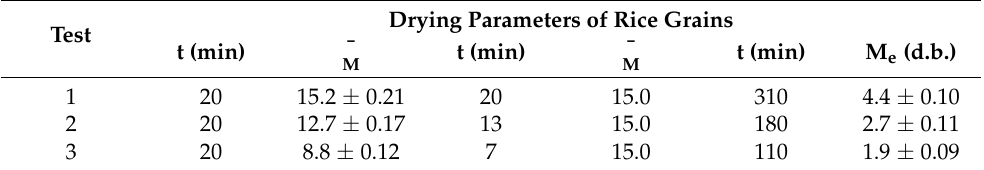
Figure 3. Effect of the supplied microwave power on the average moisture content of rice grains during the drying process.